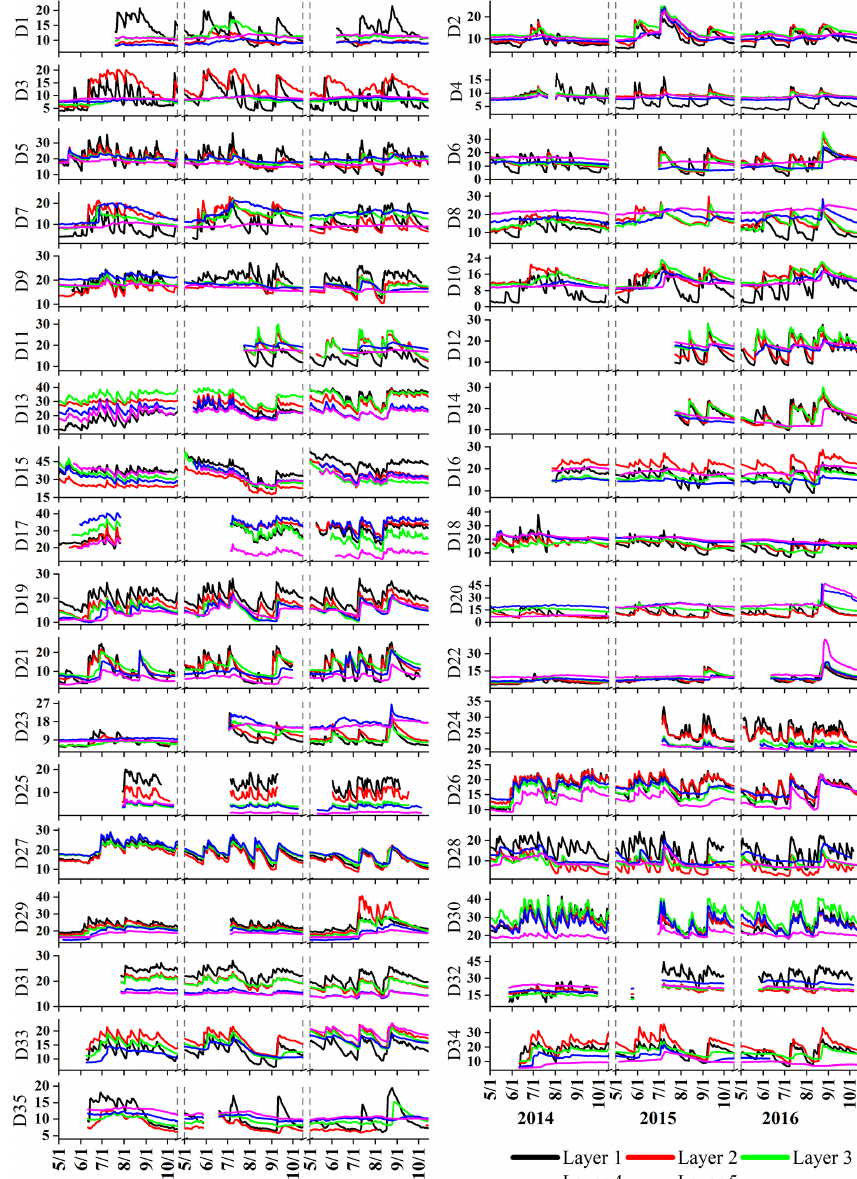
Figure 2. Daily soil moisture (vol. %) time series during the growing season of 2014 to 2016 for the five layers (layer 1, 0 to 10cm; layer 2, 10 to 20cm; layer 3, 20 to 30cm; layer 4, 30 to 50cm; layer 5, 50 to 70cm) in the 35 soil moisture stations. Gaps exist for some stations due to missing